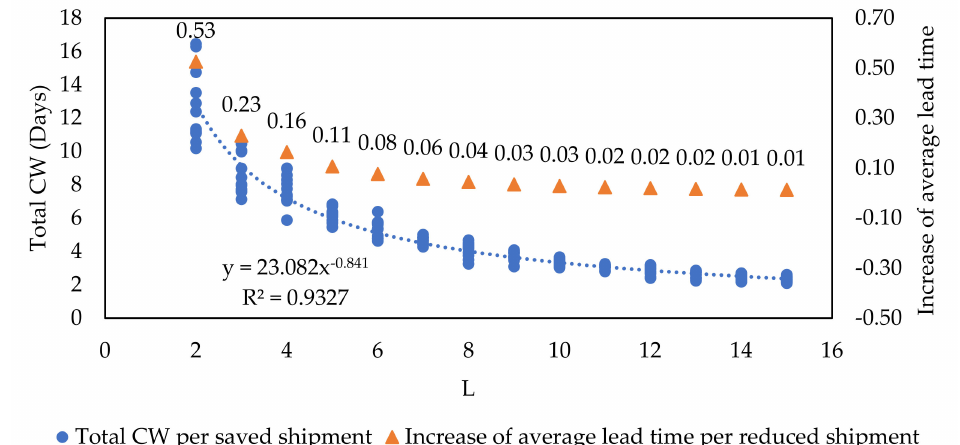
Figure 8. Total CW and increase of average lead time per reduced